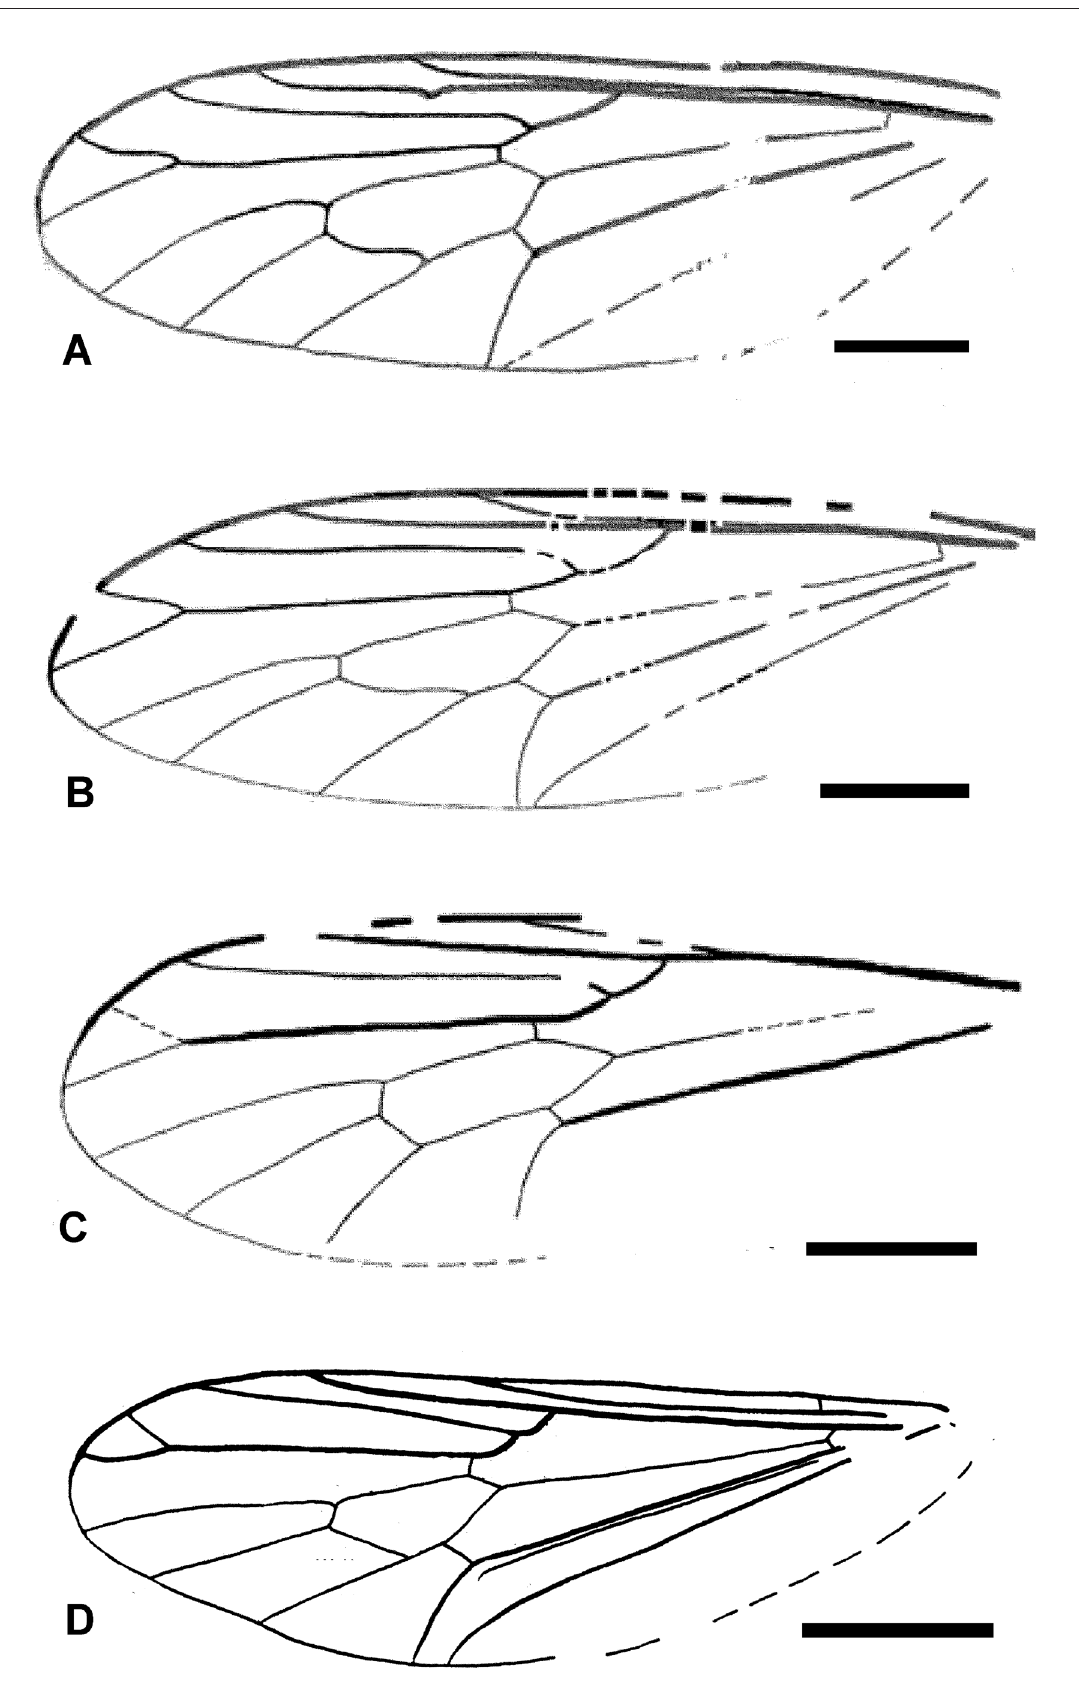
Figure 3. Difference and similarity between four sets of wings, line drawings of holotypes, A Flagellisargus ( Flagellisargus ) sinicus J Zhang, 2012a, B Flagellisargus ( Flagellisargus ) venustus J Zhang, 2012a, C Flagellisargus ( Flagellisargus ) robustus J Zhang, 2012a, D Flagellisargus ( Changbingisargus ) parvus subgen. et sp. n. Scale bas 1